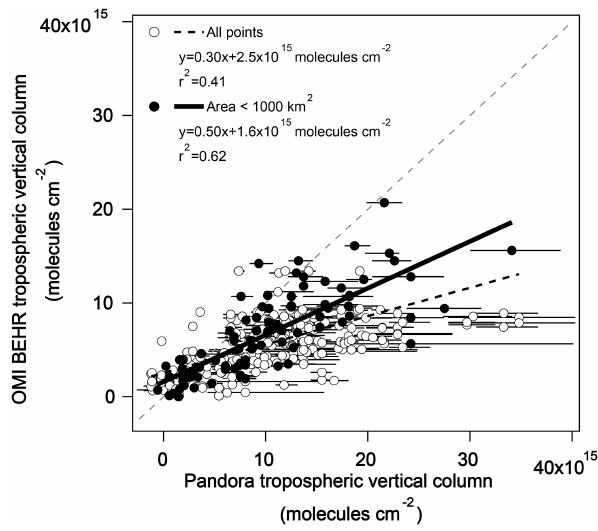
Figure 11. OMI native pixel BEHR NO 2 tropospheric vertical col- umn data vs. Pandora NO 2 tropospheric column. The filled cir- cles indicate pixel areas less than 1000km 2 . The linear fit to all points is shown in dashed black and the linear fit for pixels less than 1000km 2 is shown in solid black. Horizontal whiskers show the maximum and minimum of Pandora data ± 5min of the OMI overpass. The thin dashed line is the 1 : 1